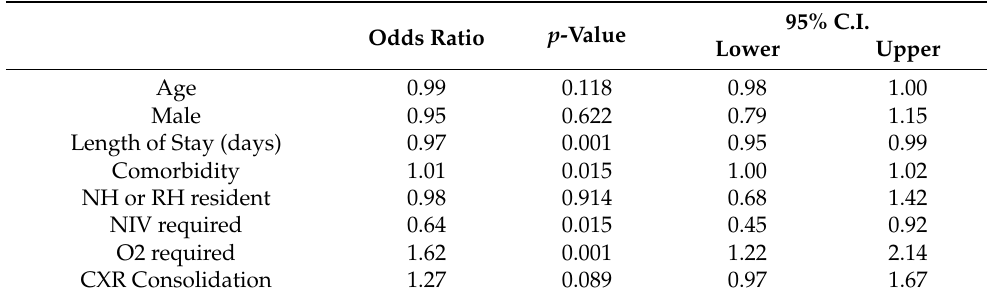
Table 3. Results from regression analysis: variables independently associated with admission during COVID-19 Period.